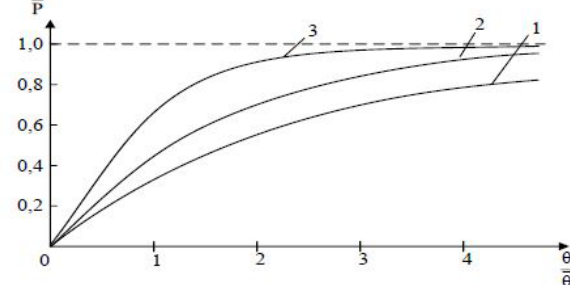
Figure 1. Dependence of probability of duration of examinations for exponential – 1, log-normal – 2 and truncated-normal – 3 distributions